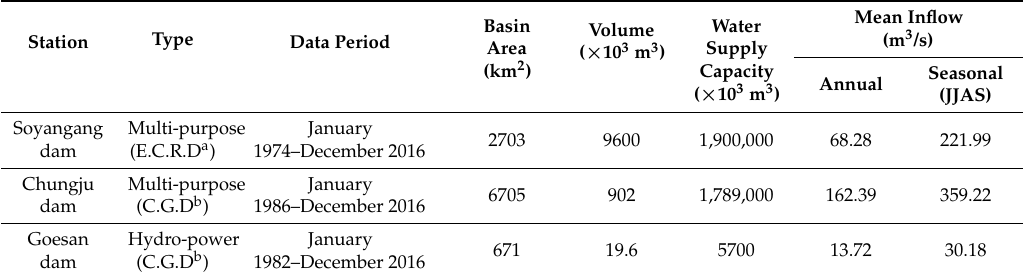
Figure 4. Locations of the Soyangang (SY), Chungju (CJ), and Goesan (GS) dams and their basins. Table 1. Detailed information about the SY, CJ and GS